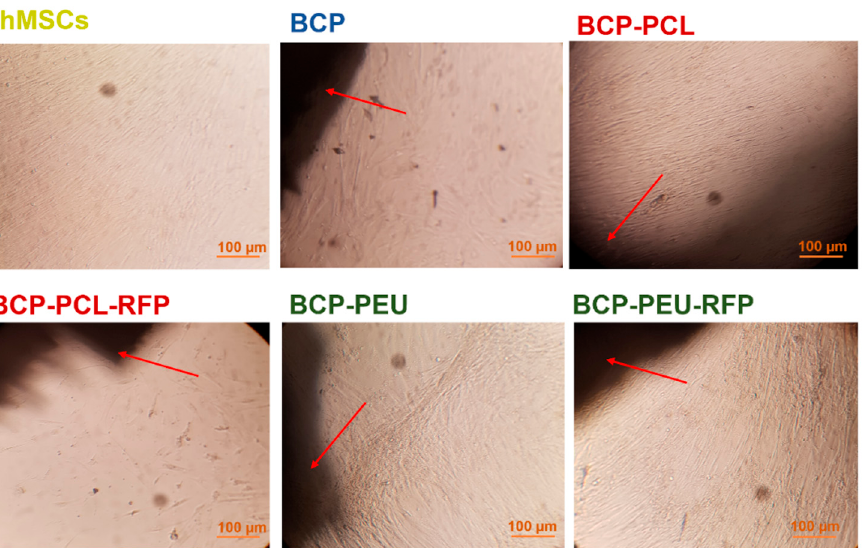
Figure 5. Images of hMSCs observed using an inverted microscope (scale bar, 100 µm), after 14 days of culture. Control group (cell culture plate), BCP scaffold, BCP-PCL scaffold, BCP-PCL-RFP scaffold, BCP-PEU scaffold, BCP-PEU-RFP scaffold.